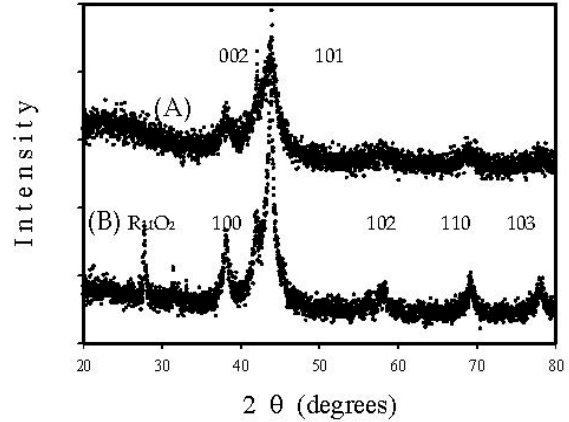
Figure 4. X-ray diffraction (XRD) patterns of reduced Re-Ru@SiO 2 particles with Ru/Si atomic ratios of (A) 0.4 and (B) 0.8.